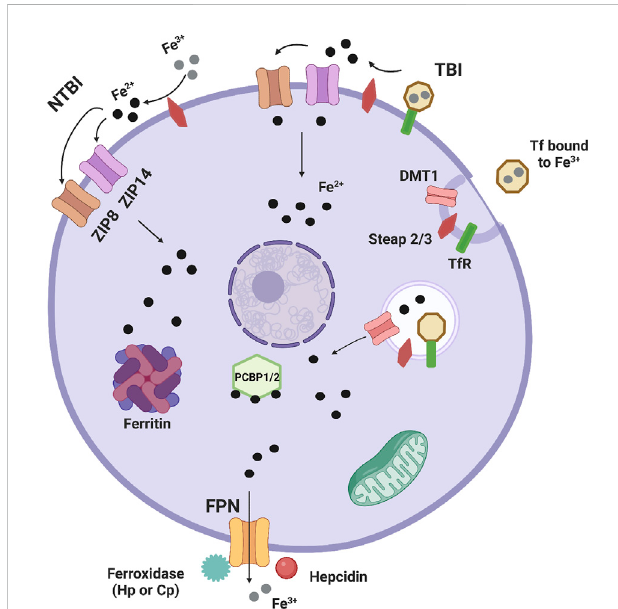
Basic cellular iron metabolism. This is an image showing basic mechanisms of iron handling in cells. Most iron is transported into tissue systems and cells through the canonical transferrin/transferrin receptor pathway. Transferrin (Tf) in serum binds to serum ferric iron (Fe3+), andthento acell ’ stransferrin receptor(TfR). Atthispoint, thecomplexis endocytosed. Then, iron is reduced by the ferrireductase Steap2/3, after which it can leave the endosome through the divalent metal transporter 1(DMT1). Non-transferrinbound iron(NTBI)uptakealso occurs.The fi rst pathway involves reduction of extracellular ferric iron (Fe 3+ ) by Steap2/ 3 and ferrous iron (Fe 2+ ) entering the cell by either ZIP8 ( SLC39A8 ) or ZIP14 ( SLC39A14 ), two divalent metal ion transporters that can also transport Zn 2+ and Mn 2+ . In another pathway, Fe 3+ bound to Tf and the TfRisreducedbySteap2/3andentersZIP8orZIP14fortransportintothe cell, highlighting that TBI can also be transported by ZIP8/14. Once the ironiswithinthecell,itcanbeshuttledtotheironstorageproteinferritin by PCBP1/2 or taken to the mitochondria for iron-sulfur cluster and heme assembly. Iron ef fl ux from cells is mediated by the ef fl ux transporter ferroportin (FPN), which works with a ferroxidase, either ceruloplasmin (Cp) or hephaestin (Hp) to oxidize Fe 2+ to Fe 3+ , allowing proper ef fl ux. Lastly the acute phase protein hepcidin is well known to induce internalization of FPN leaving this protein non-functional and reducing iron ef fl